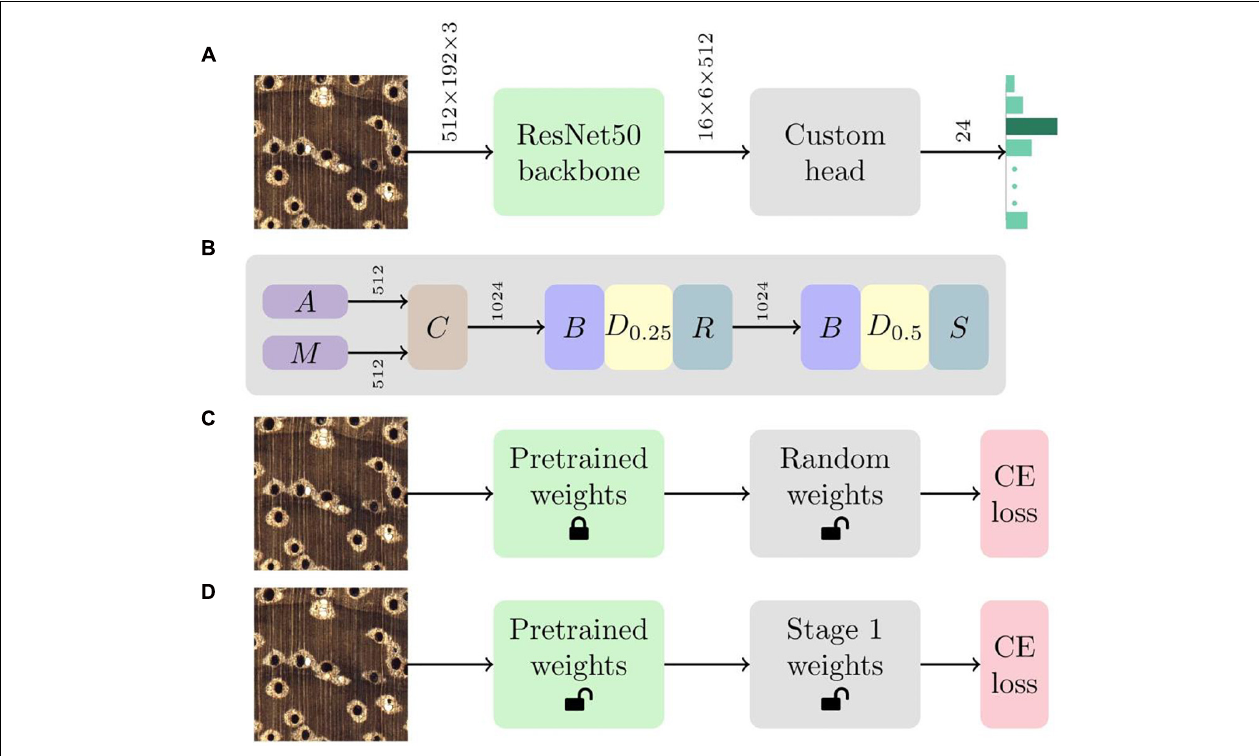
FIGURE 1 | (A) The CNN architecture comprises a ResNet50 backbone with a custom head. Given an input image, the network produces a 24-element vector that represents the prediction confidence for each of the 24 classes in the model. Tensor dimensions are depicted over the connections between the modules. (B) The custom head includes global average pooling (A), global max pooling (M), concatenation (C), batchnorm (B), dropout (D) and linear layers with ReLU (R) and softmax (S) activations. D p represents a dropout layer with drop probability parameter p. Tensor dimensions are depicted over the connections between the layers. (C) The first stage of transfer learning locks (or freezes) the ImageNet pretrained weights of the ResNet50 backbone and optimizes the randomly initialized weights of the custom head using the cross-entropy (CE) loss. (D) The weights of the entire network are fine tuned using the CE loss during the second stage of the training methodology.